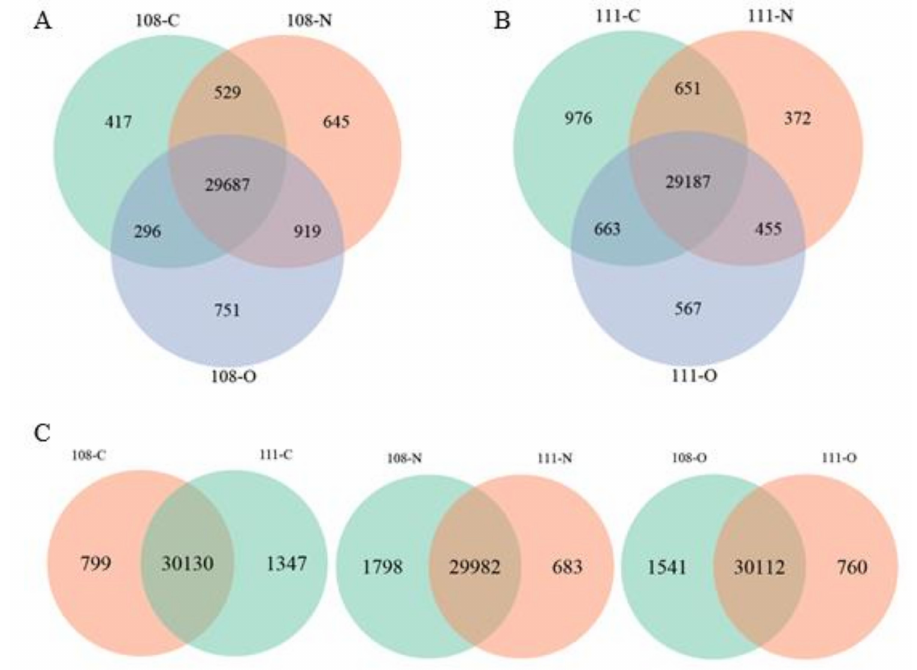
Figure 2. Gene expression analysis of the ‘108’ and ‘111’ treatment groups. Venn diagrams representing the gene expression of ( A ) control, neighboring, and oviposited leaves of ‘108’, ( B ) control, neighboring, and oviposited leaves of ‘111’, and ( C ) control, neighboring, and oviposited leaves of ‘108’ and ‘111.’ C, control; N, neighboring; O,